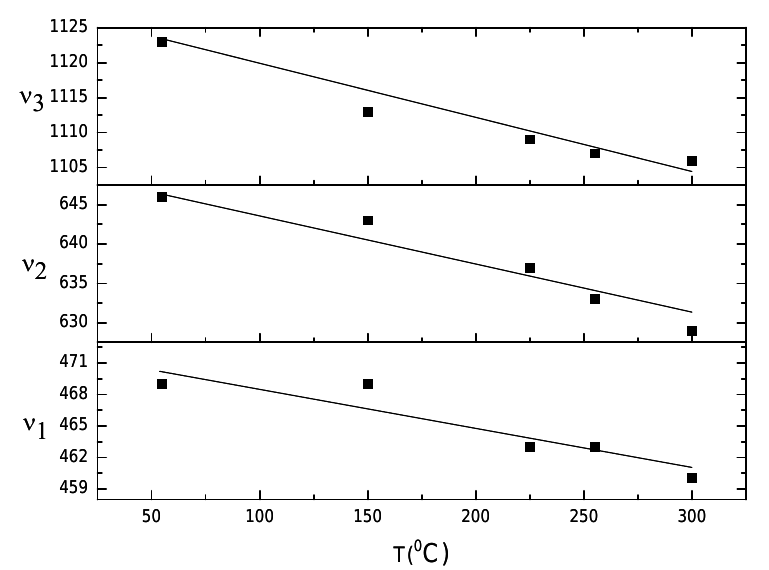
Figure 6. The dependence of Li vibrations on temperature in the range from 55 to 300